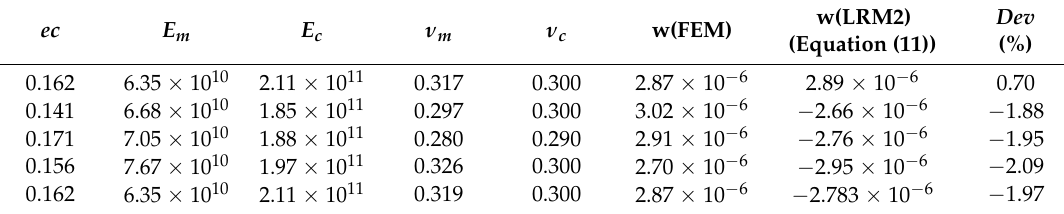
Table 12. Verification of statistic model LRM2 (case study 1, thicker core).